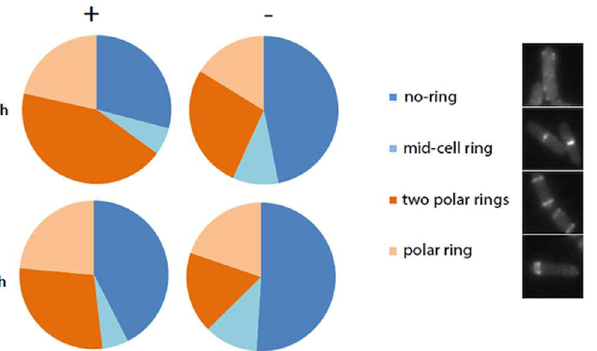
Fig 3. The absence of Mn 2+ from the sporulation medium delays asymmetric Z-ring formation. Pie- chart representation of sporulating B . subtilis cells in the presence(+) and absence(-) of Mn 2+ . Four different types of cell (representative images in the legend)were scored: cells without any Z-ring in the cell (no ring), cells with a Z-ring in the middle of the rod (mid-cell ring), cells with two rings assembledat the cell poles (two polar rings) and cells with only one polar ring (polar ring). Non-sporulating cells are marked in blue shades, whilesporulatingcells are marked in orangeshades. Each pie chart is the result of two independent classification experiments in which at least 290 cells were classifiedper condition. Actual percentages and standarddeviationsare includedin S1 Table.